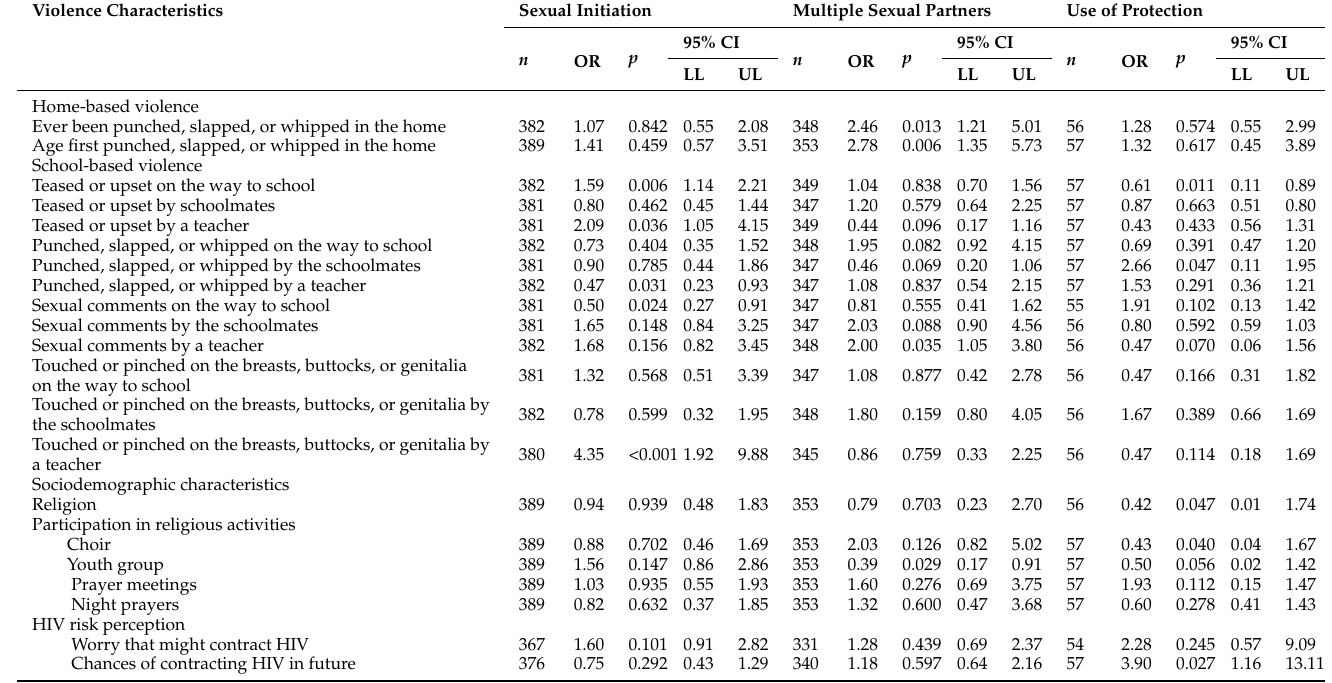
Table 3. Bivariate associations between violence and sociodemographic characteristics and sexual behavior, ( N =